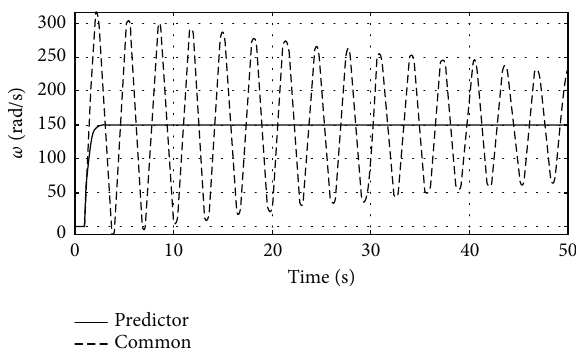
Figure 12: Comparing a predictive-based H common H controller for τ � 0 . 8s. ∞